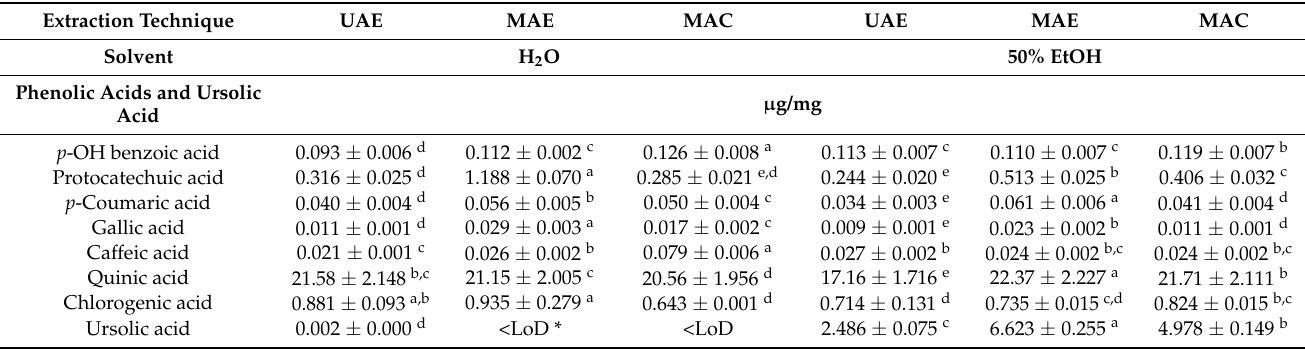
Table 1. Concentration * of detected ** phenolic acids in elderberry extracts ( µ g/mg extract).